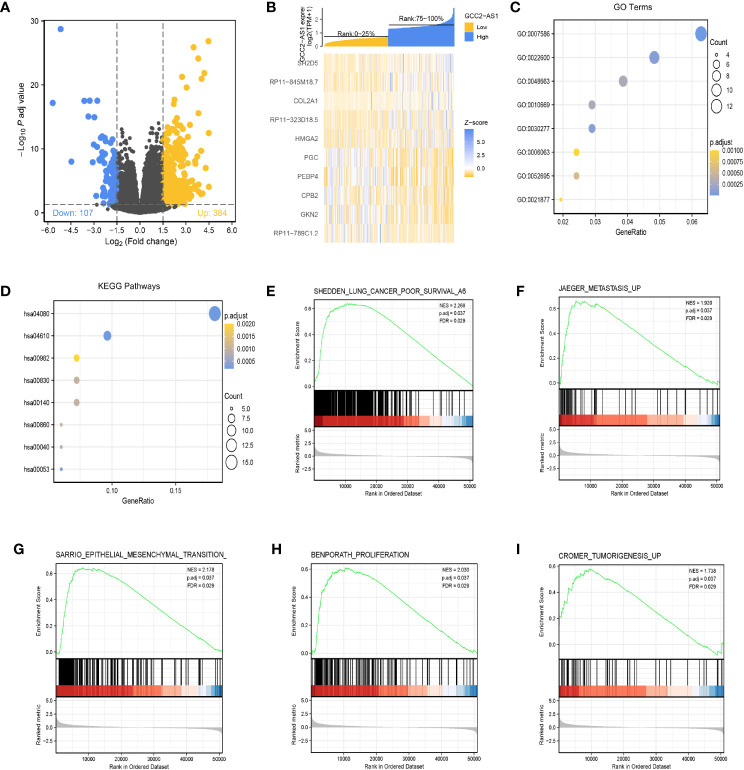
Identification of differentially expressed genes (DEGs) in the GCC2-AS1-low and -high patients and enrichment analysis in the TCGA database. (A) Volcano plot of DEGs. (B) Heat map of the top 10 DEGs. (C) GO enriched terms colored by P-value. (D) KEGG enriched terms colored by P-value. GSEA results revealing that poor survival (E), metastasis (F), epithelial mesenchymal transition (G), proliferation (H), and tumorigenesis (I) were significantly were enriched in the high GCC2-AS1 expression group. NES, normalized ES; FDR, false discovery rate.